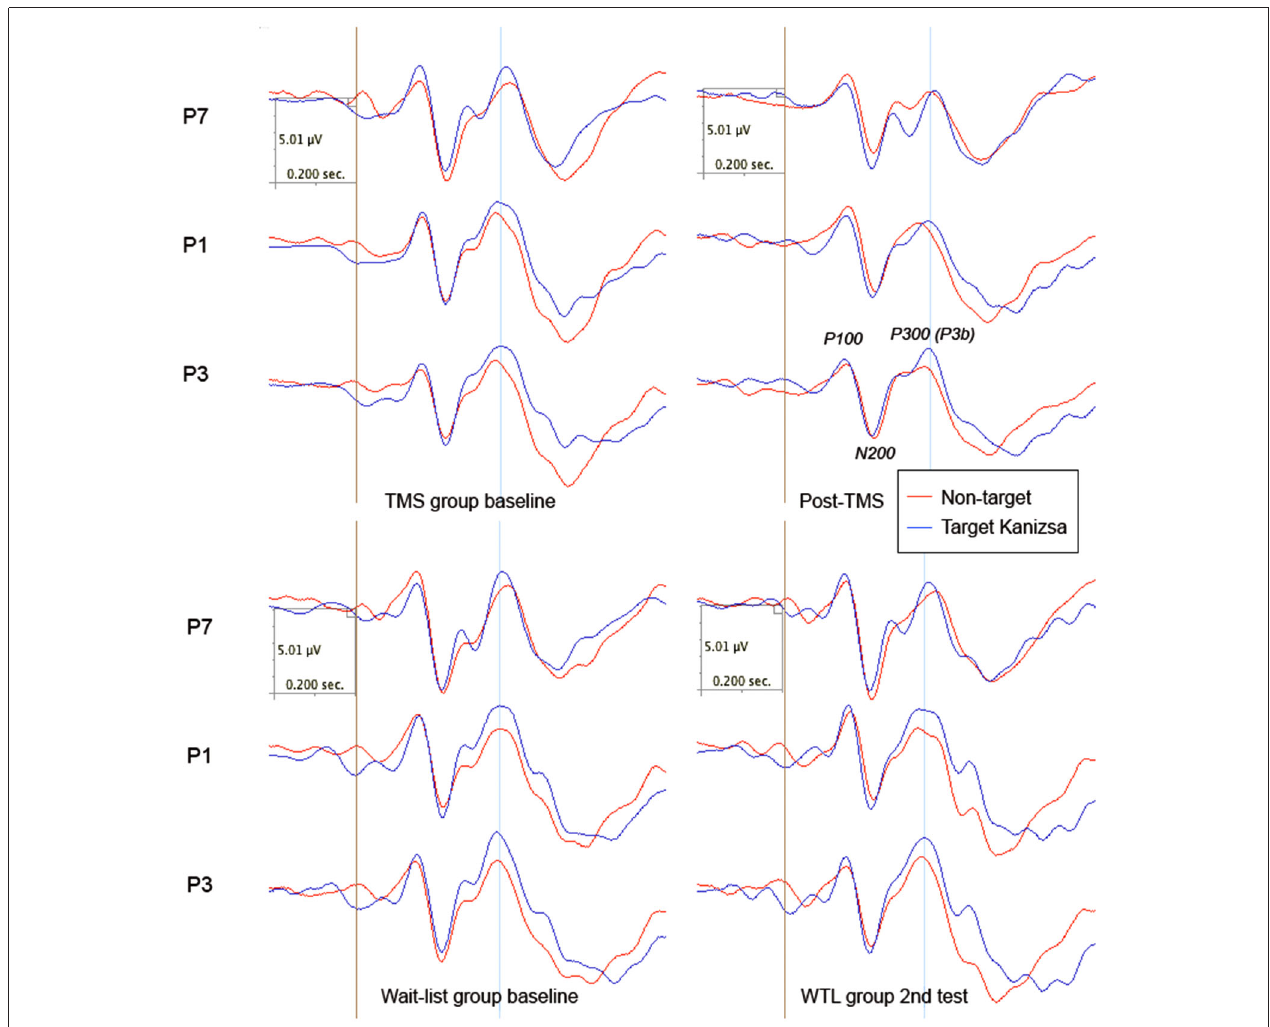
FIGURE 3 | Parietal ERPs (P1, P3, P7 sites according to 10–10 International System) to target and non-target Kanizsa figures in TMS and wait-list groups ( N = 27/per group) before and after treatment (TMS/or